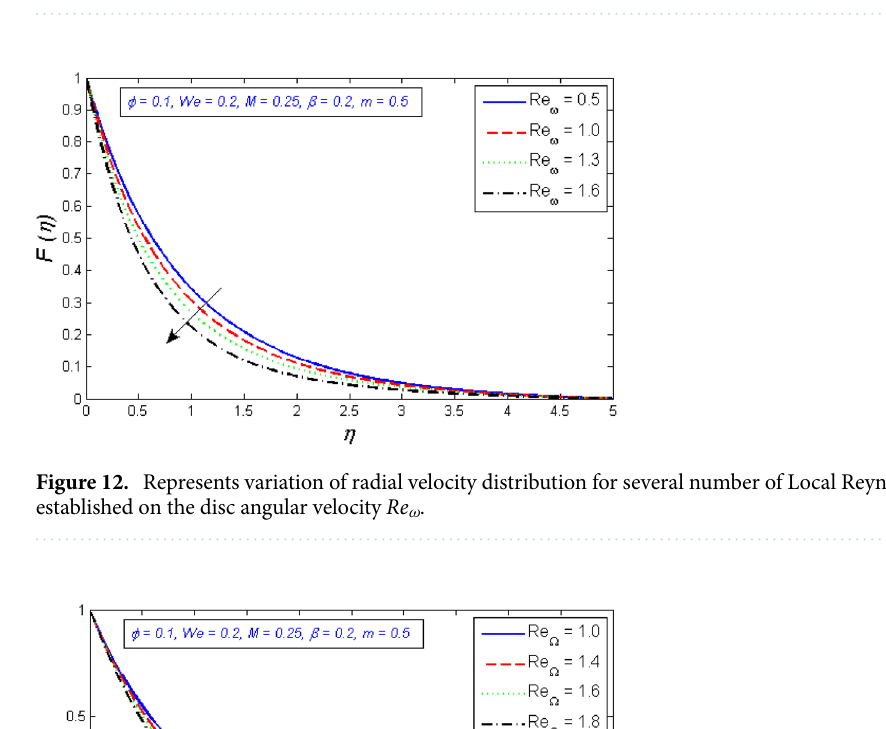
Figure 11. Represents variation of tangential velocity distribution for several number of Hall parameter m .